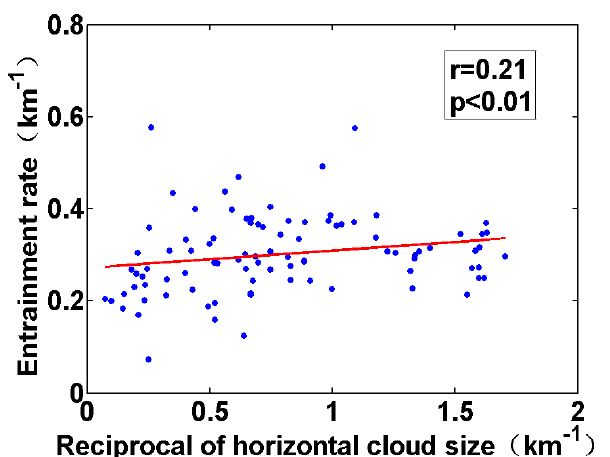
Figure 7. Entrainment rate as a function of the reciprocal of horizontal cloud size and also provided in legend is the correlation coefficient ( r ) and the p value of the